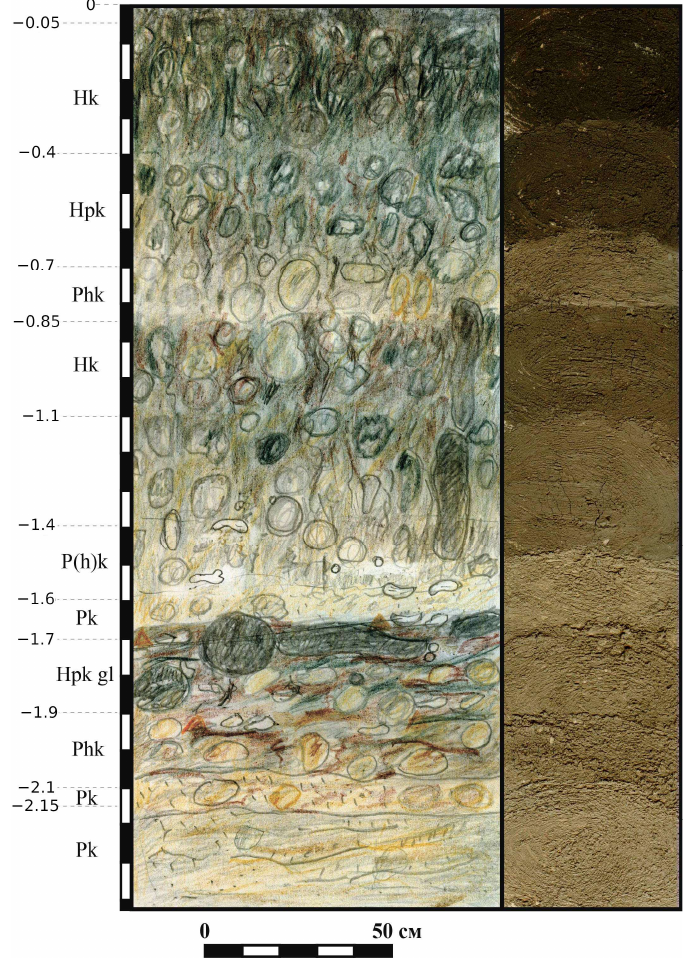
Figure 10. Melnychna Krucha. Soil-section 1. Captions: see Supplementary Table S4. Left column: soil horizons’ indices, dotted lines indicate changes of horizons; central column: schematic drawing; right column: photos of actual soil textures from respective horizons of the section, taken afield by gluing a respective sample to a sheet of paper.